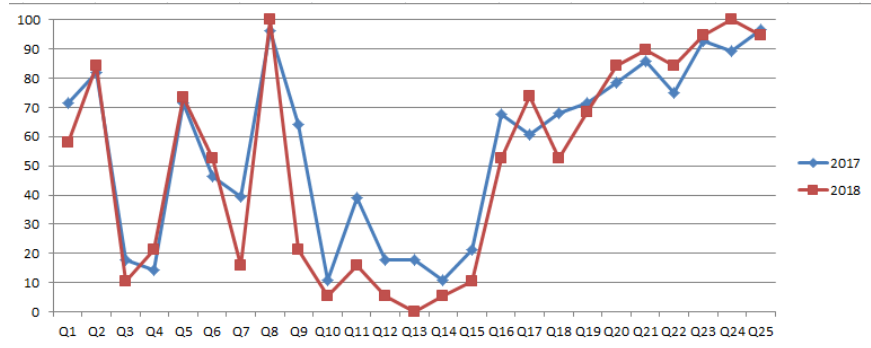
Figure 10. Sums of percentages of Option 1 and Option 2 in 2017 and 2018.